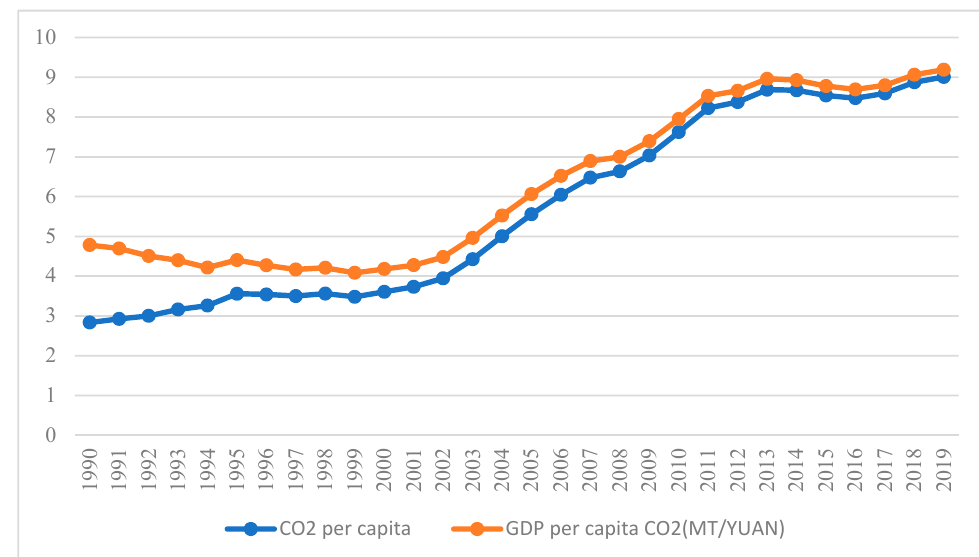
Figure 2. 1990–2019 CO 2 per capita and CO 2 per GDP in China. Data source: World Bank/our- worldindata.org.